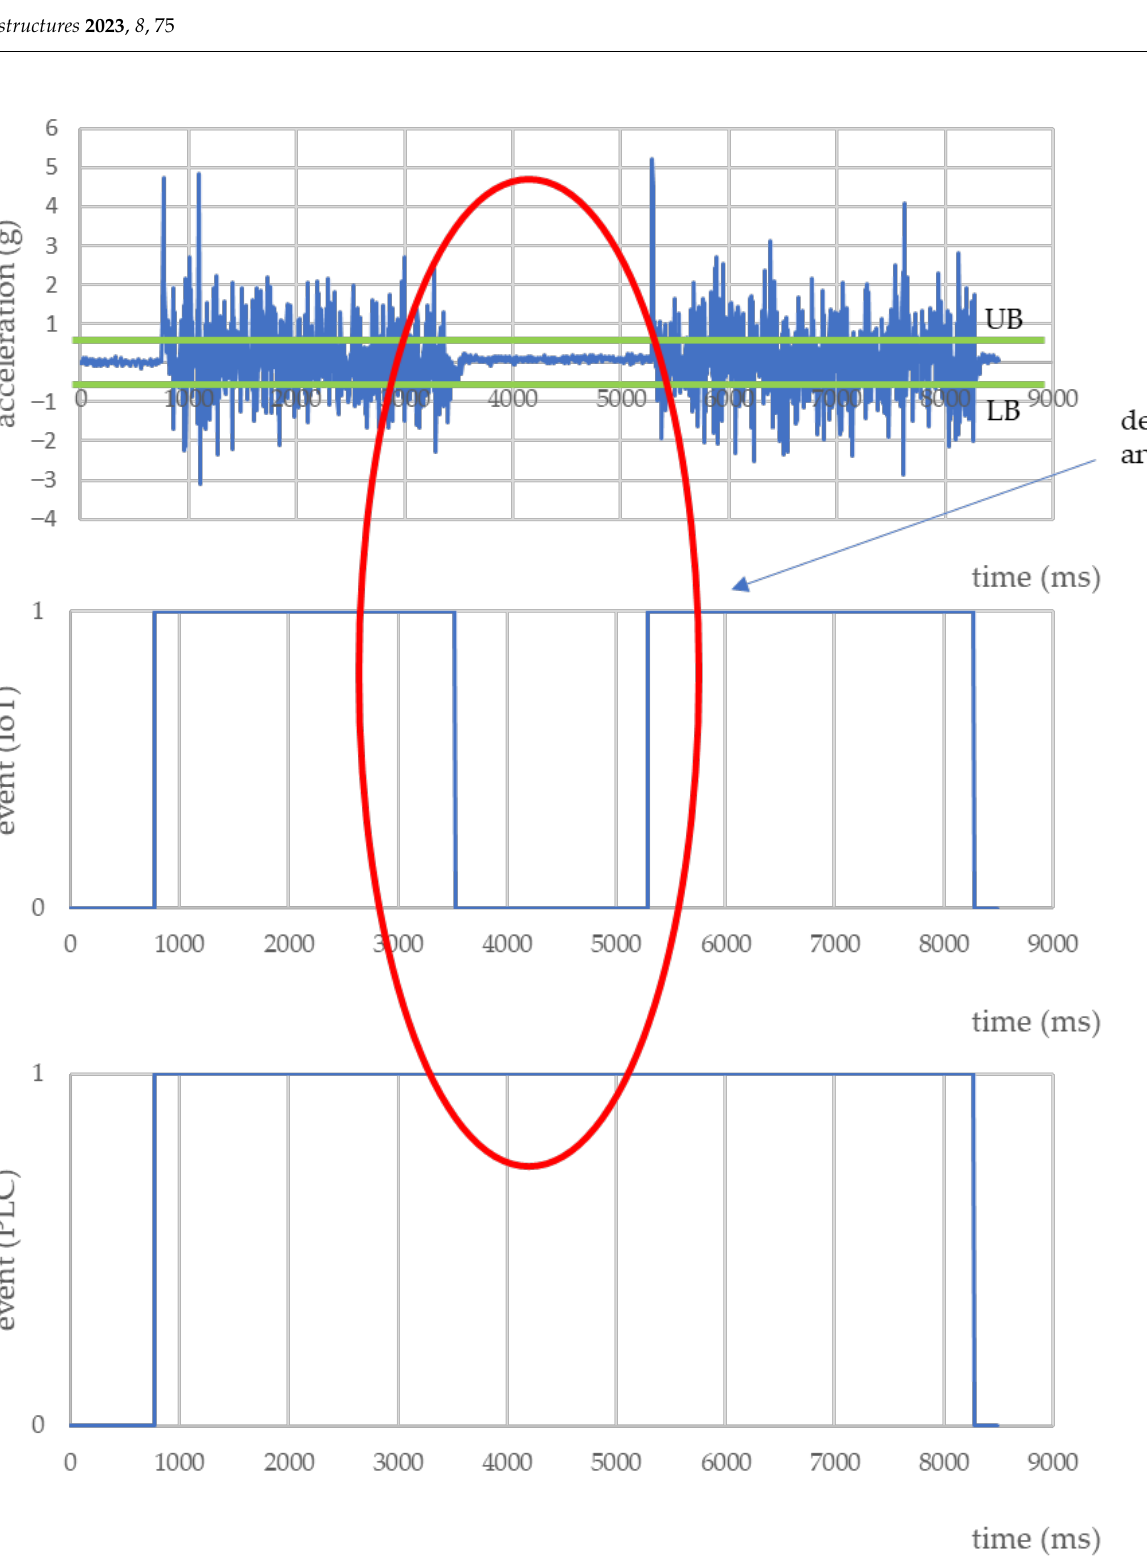
Figure 6. Anomaly detection (raw acceleration data, event from IoT, event from PLC).